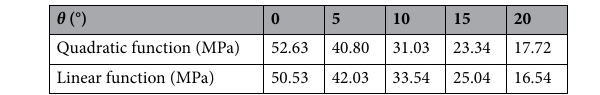
Table 7. Pillar strength under different inclination